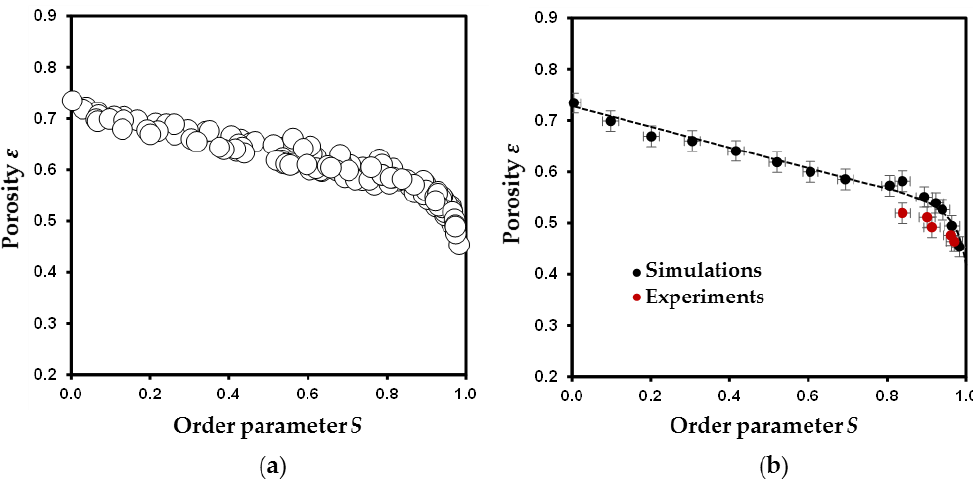
Figure 3. Evolution of porosity ε as a function of order parameter S for simulated disk packings. ( a ) The 135 disk packings obtained with different degree of freedom in particle motions. ( b ) Selection of 15 disk packings (solid circles) and comparison with experimental porous media (solid red circles). The doted curve highlighting the ε vs. S master curve is plotted as guideline.